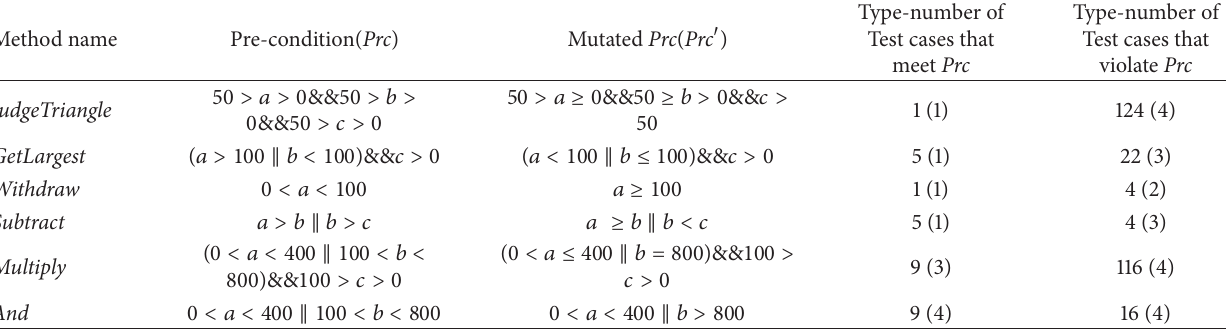
Table 4: Testing result for TestCondiDll1 using condition mutation.